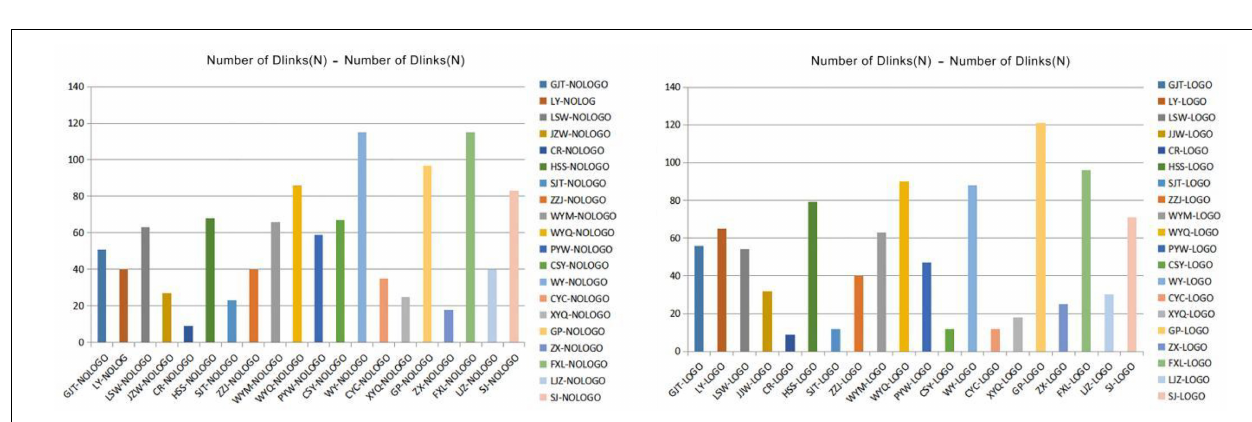
FIGURE 10 | Statistics of the number of times the testees blink in scenes A and B (Search and take screenshots from ErgoLAB by our research